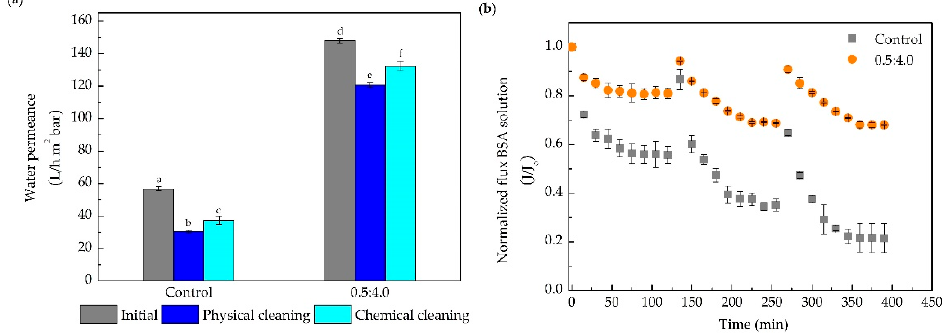
Figure 8. Membrane regeneration experiments of the control and modified membranes with 0.5:4.0 mg mL − 1 of DA and PEI in the filtration of BSA solution (2.5 g L − 1 ). ( a ) Water permeance before the protein filtration (initial) and after the physical and chemical cleaning (after three cycles of BSA filtration). ( b ) Normalized permeate flux of the BSA solution. Bars with different letters show a statistical difference ( p < 0.05).